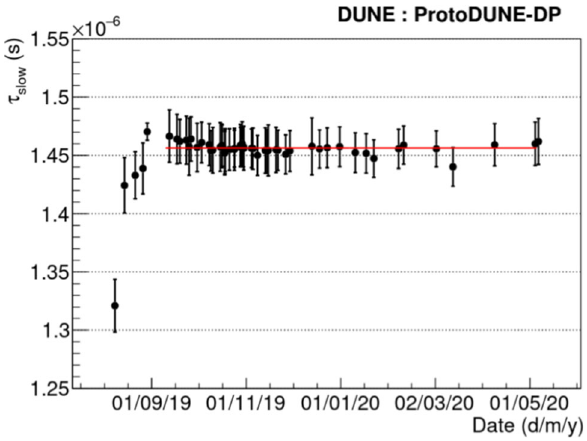
Fig. 10 Example of the average scintillation waveform of a PEN PMT (blue). The fit to Eq. 6 is shown in red. The corresponding parameters are shown in the legend